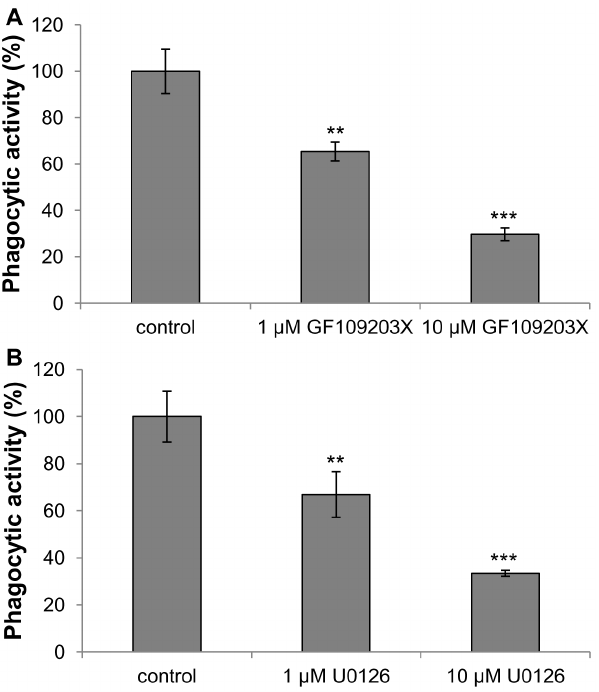
Figure 8. Effect of PKC (GF109203X) and MEK (U0126) inhibitors on phagocytosis by haemocytes from uninfected Radix lagotis . Haemocyte monolayers were pre-incubated with (A) GF109203X, (B) U0126, or vehicle (DMSO; shown as controls) prior to challenge with E. coli bioparticles. The intracellular fluorescence resulting from phagocytosis was measured using a microplate reader and mean ( 6 SEM; n=7) levels of phagocytosis expressed in relation to control (100%) values. **p , 0.01, ***p , 0.001, when compared to control values; paired t-test.